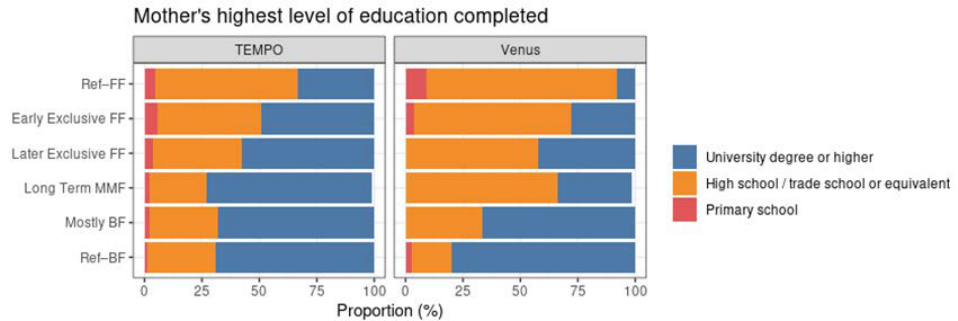
Figure 8. Distribution of mothers’ highest level of education completed within each MMF cluster for TEMPO (left) and Venus (right).